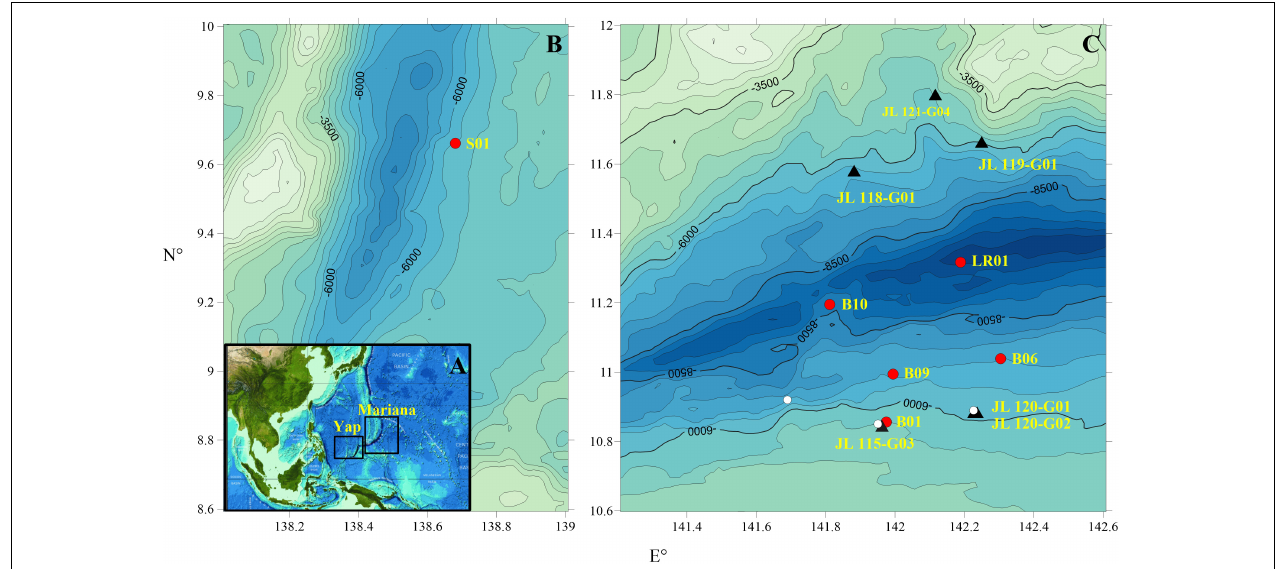
FIGURE 1 | (A) The locations of Yap and Mariana trenches at the northwest Pacific Ocean. (B) Regional bathymetric map and the S01 sampling site at the northern Yap trench. (C) Regional bathymetric map and the sampling sites at the Mariana Trench. The black triangles represent the rock samples and red circles represent the sediment cores. The lately discovered fluid discharge field and pockmarks on the incoming plate of Mariana trench are marked in white circles (Du et al.,